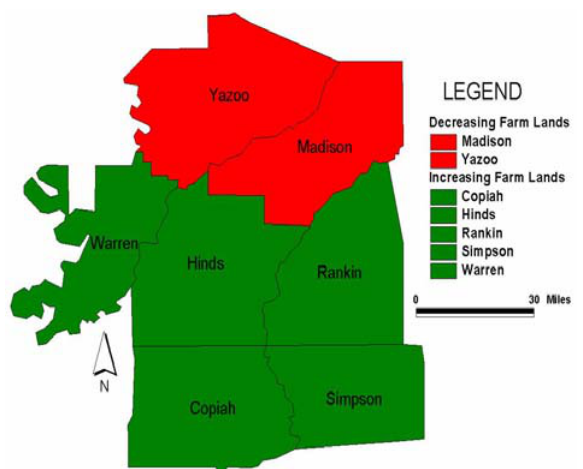
Figure 2.1 : Counties with Increasing and Decreasing Farm Lands from 1987-2002